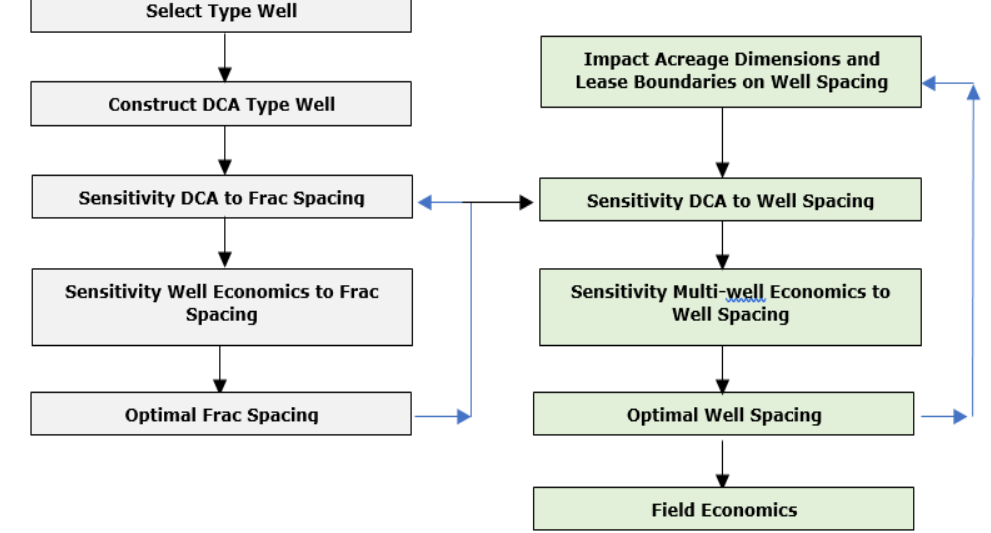
Figure 3. Workflow for optimizing fracture spacing and well spacing given particular acreage dimensions. Process can be repeated for selected type wells to determine the optimized net present value (NPV) for the entire field. After [6].